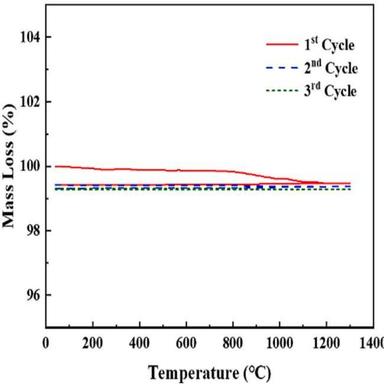
Thermal gravimetric analysis of pretreated steel slag.